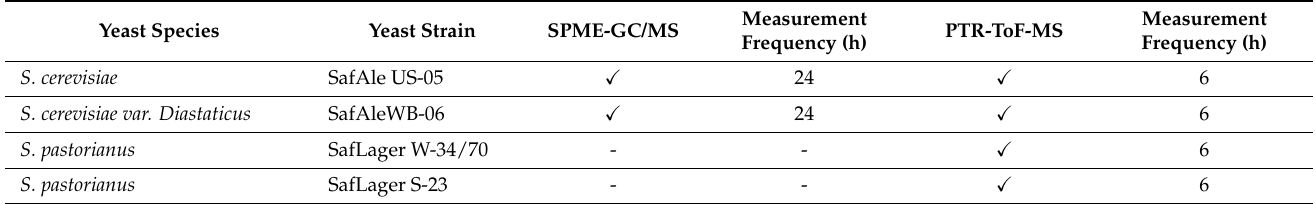
Table 1. An overview of the samples measured with SPME-GC/MS and PTR-ToF-MS. Yeast